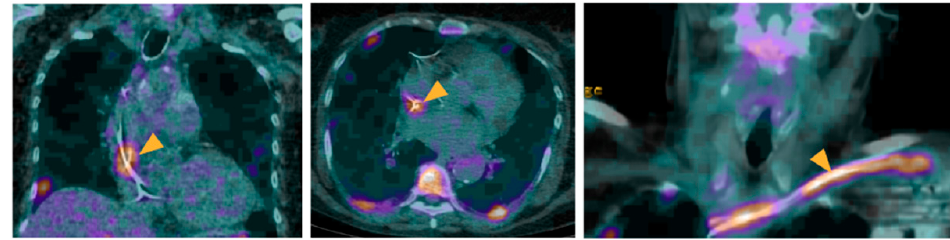
Figure 2. Role of 18 F-FDG-PET/CT in a patient with a suspicion of IE on CIED. A 55-year-old male patient with a history of pacemaker implantation presented with a fever of unknown origin. No clinical sign of pocket infection was observed. Blood culture tested positive for Streptococcus viridans . Echocardiography evidenced no sign of CIED-IE. 18 F-FDG-PET/CT showed an intense 18 F-FDG uptake located at the level of the extra-cardiac portion of the lead (arrowheads), suggestive of a lead infection. The presence of two major criteria classified the patient as with definite IE . The patient further underwent an extraction of the device, which culture confirmed the diagnosis of CIED-IE, as well as prolonged